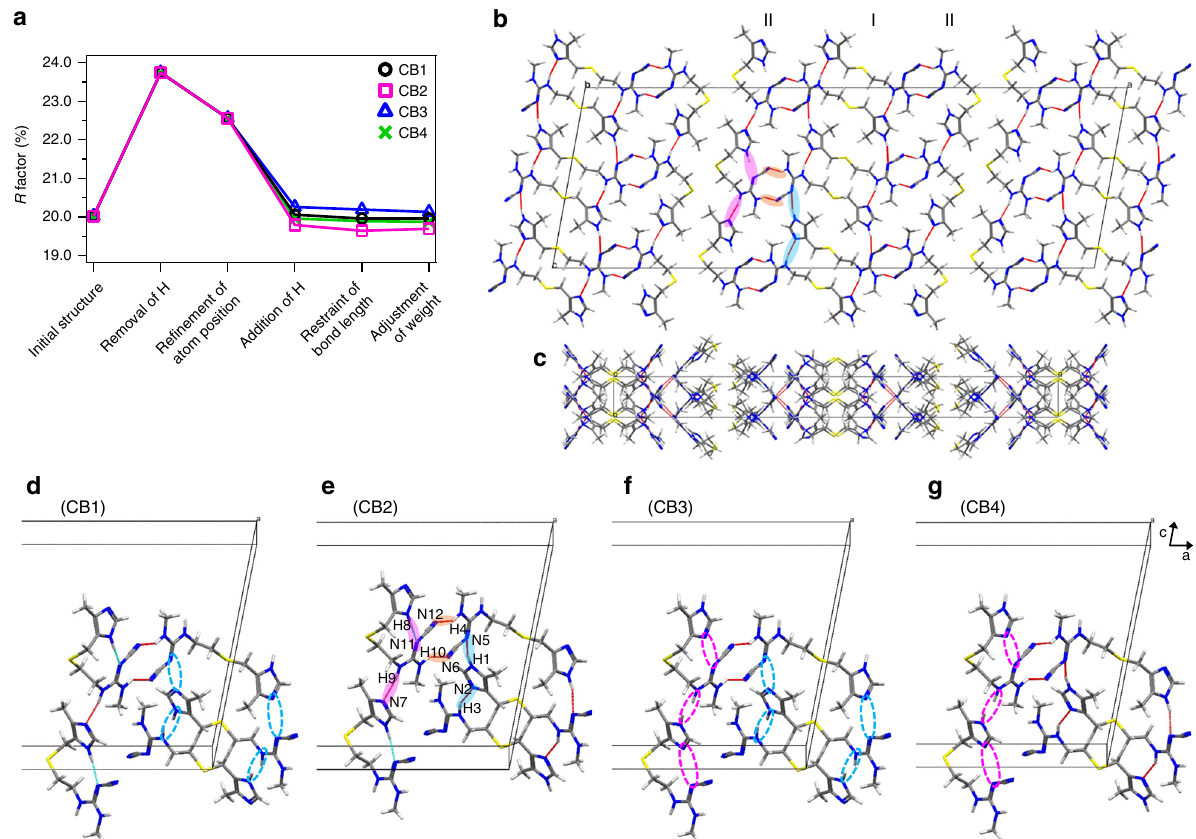
Fig. 6 Cimetidine form B crystal structure and its hydrogen-bonding network. a Variation of the R factor (%) after each re fi nement step as determined using the SHELXL software. Hydrogen-bonding network of the CB2 structure in b ac and c ab planes. For the sake of simplicity, only intermolecular hydrogen bonds are shown as red lines. b , e The pink and sky-blue solid circles indicate the hydrogen bonds between I conformations and between II conformations, respectively. The orange solid circles represents the hydrogen bonds between I and II conformations. d – g Extraction of hydrogen bonds for the d CB1, e CB2, f CB3, and g CB4 structures. The unit cell consists of adjacent molecules connected by intermolecular hydrogen bonds. The inter- and intramolecular hydrogen bonds are depicted by red and sky-blue lines, respectively. The magenta and sky-blue broken circles denote the missing hydrogen bonds of H8···N11 and H9···N7, and H1···N5 and H3···N2, respectively. In CB2, the lengths of the hydrogen bonds were as follows: N1 – H1···N5 = 2.172 Å,